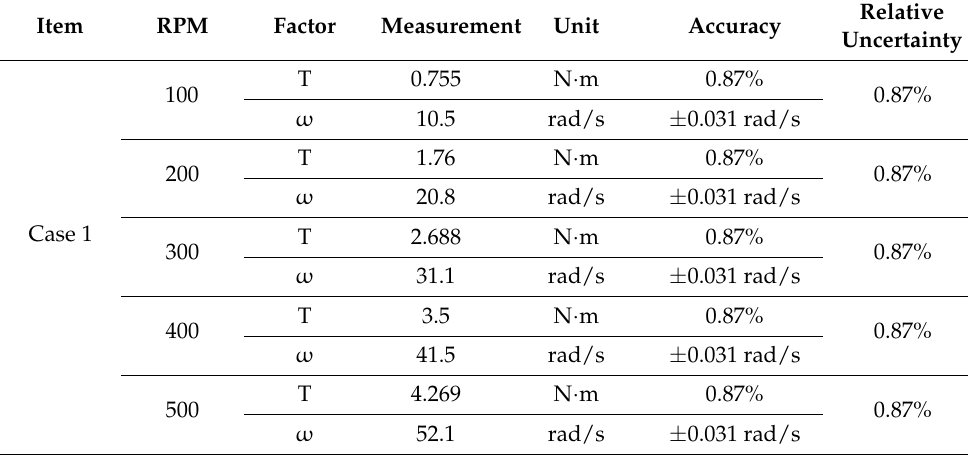
Table 4. Relative uncertainty of case 1 in terms of output